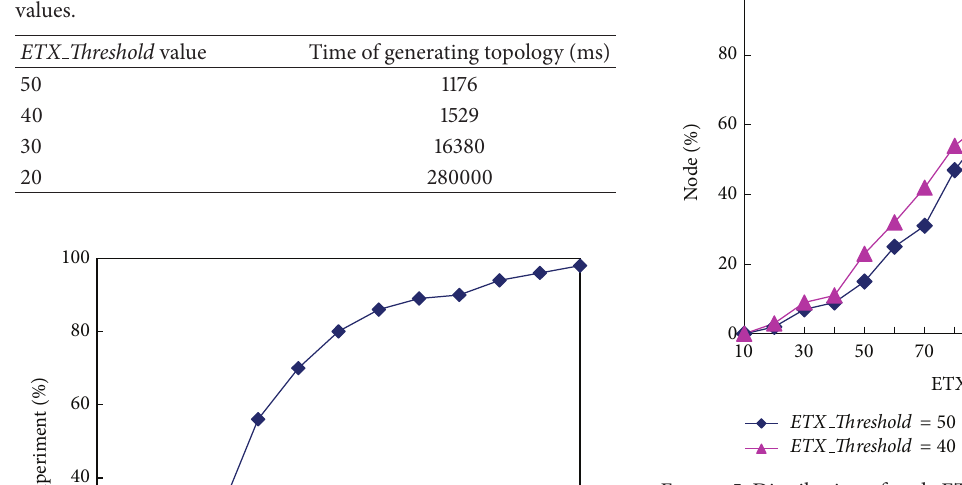
Figure 5: Distribution of node ETX when ETX Threshold is 50 and